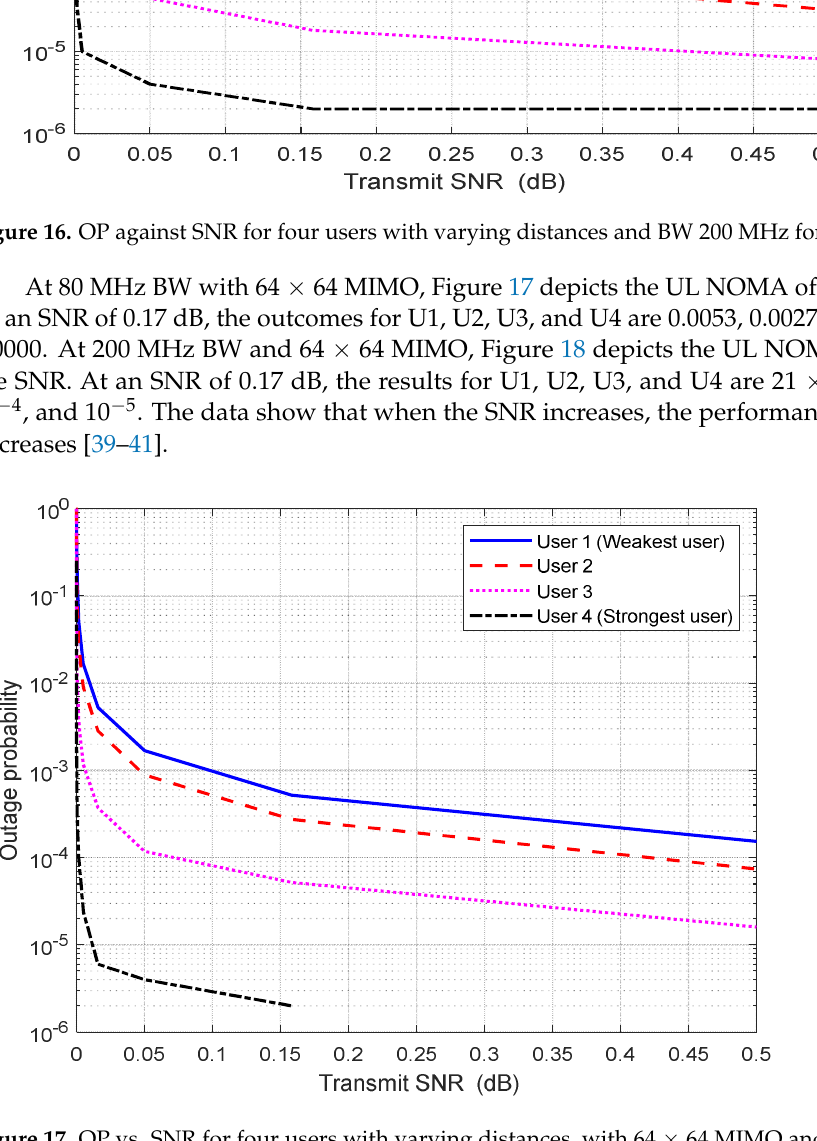
Figure 17. OP vs. SNR for four users with varying distances, with 64 × 64 MIMO and BW 80 MHz for UL NOMA.